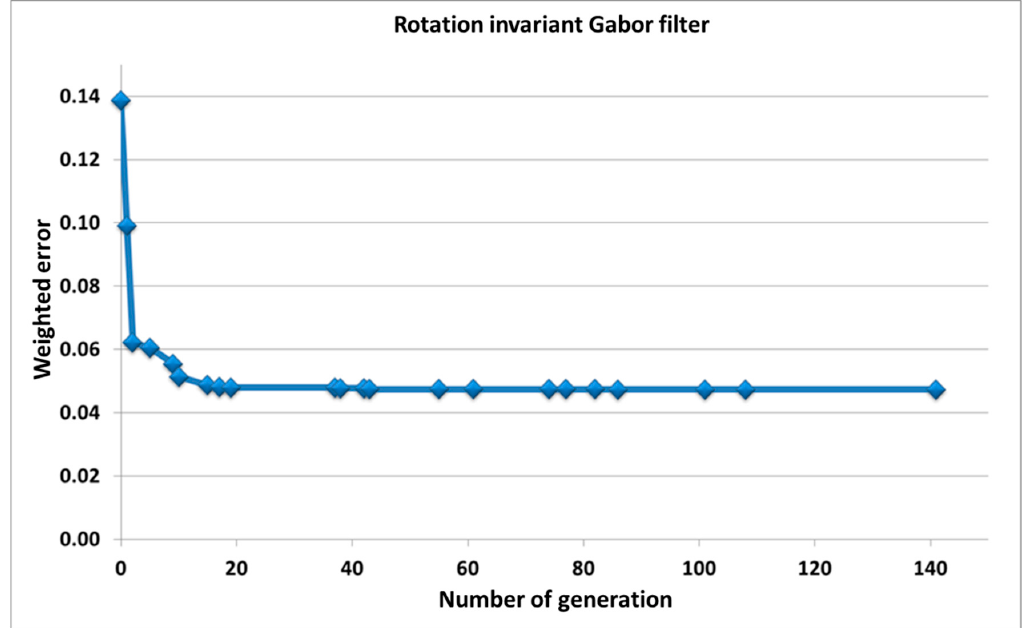
Figure 6. Evolution of the weighted error through the increase in the number of generations of the Gabor filter invariant to rotation.